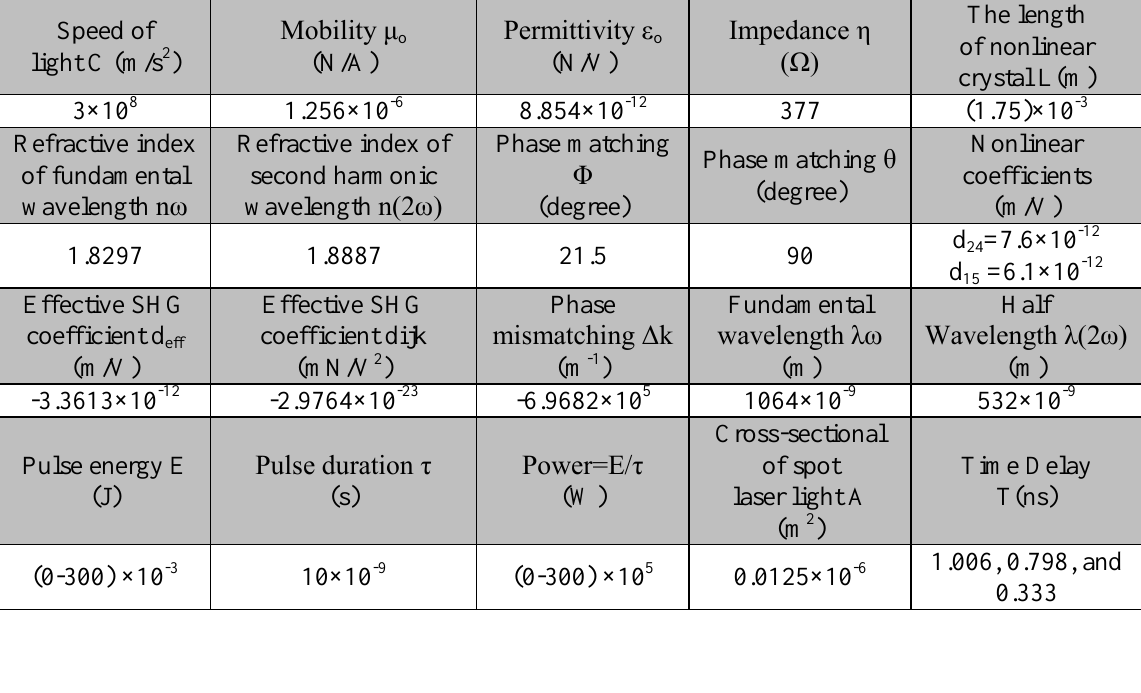
Table 3: Show most parameters of second harmonic generation setup at RT.